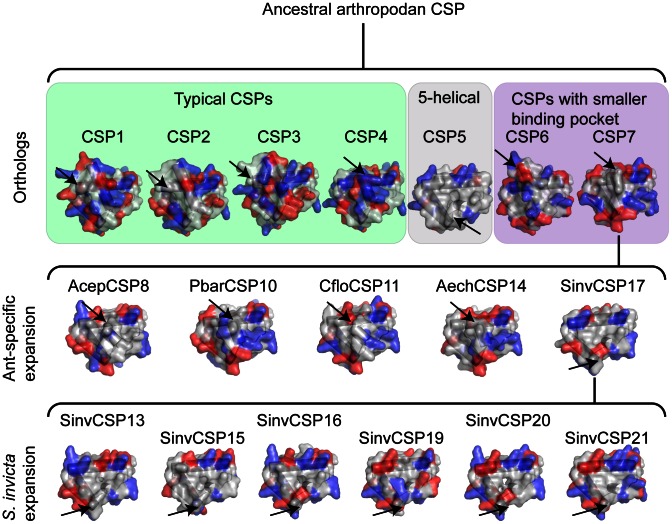
Groups of ant CSPs based on their phylogeny and structural models.All ants share seven orthologous CSPs (CSP1-7; the uppermost row of models), of which CSP7 or a protein similar to that has given rise to the ant-specific expansions (representative proteins on the middle row). The largest currently known ant-expansion is found in S. invicta (the lowest row). In the orthologs, CSP1-4 can be grouped together based on their evenly speckled surface charges and similarities in their binding pocket (“Typical CSPs”; green). CSP5 (grey) is conserved across arthropods, and is one of the oldest CSPs. It differs from the other orthologs by having five instead of six helices, a reduced charge on the surface and by changes to its binding pocket. CSP6 and CSP7 are grouped together (purple) due to mutations in their binding pocket that are likely to reduce the size of the pocket cavity. Examples of the ant-specific CSP expansion are shown; Atta cephalotes CSP8, Pogonomyrmex barbatus CSP10, Camponotus floridanus CSP11, Acromyrmex echinatior CSP14 and Solenopsis invicta CSP17. In the models, negatively charged amino acids (E, D) are shown in red and positively charged amino acids (K, R) in blue. C-termini are marked by an arrow. The S. invicta expansion proteins, together with CSP5, are one helix shorter than the other CSPs in their C-terminus, which is depicted by the altered location of the arrow in these models.